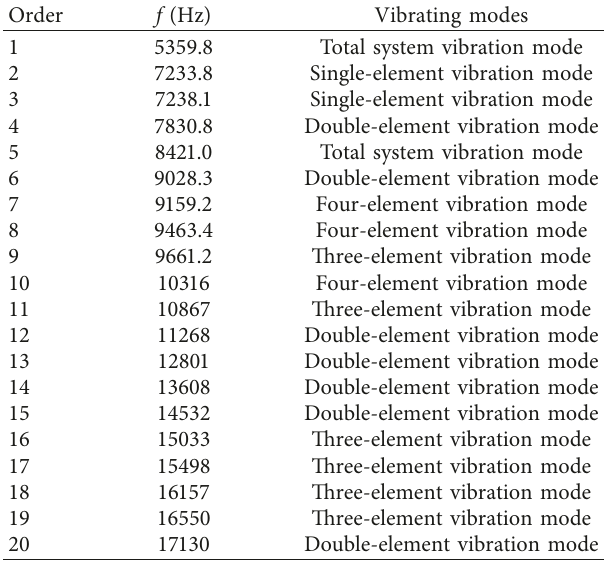
Figure 2: FEM model and mesh division of the drive system. Table 2: Natural frequencies and vibrating modes of the drive